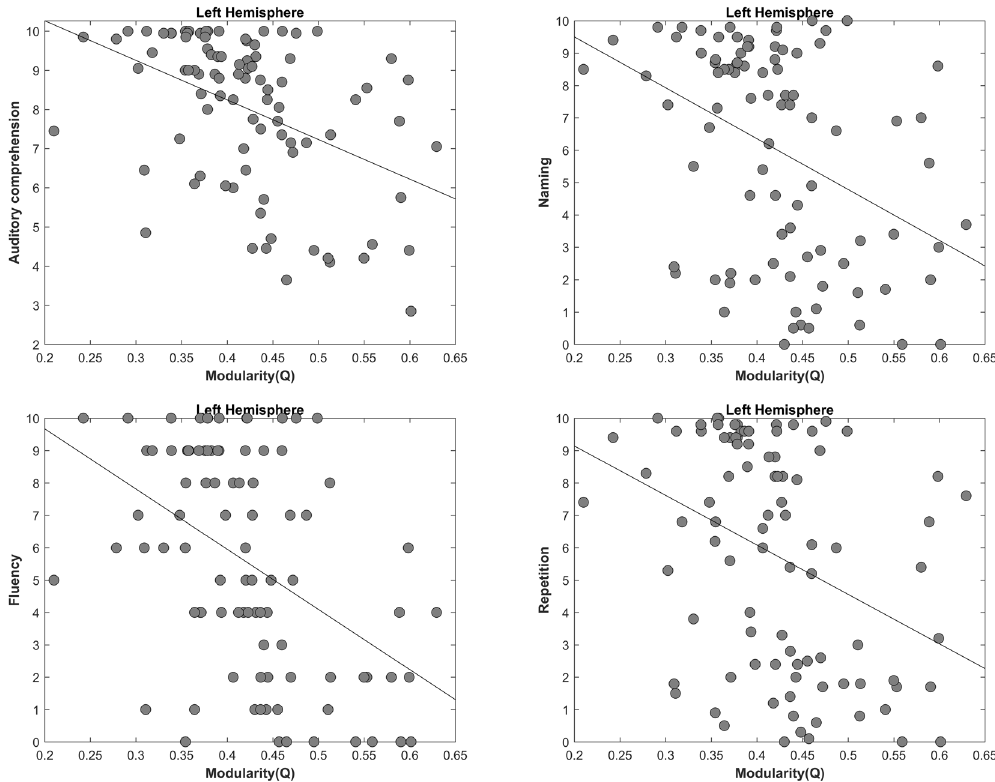
Figure 2. Correlation between left hemisphere modularity and subsets of WAB-AQ: Auditory comprehension (r = − 0.4345, p < 0.00001), Fluency (r = − 0.4561, p < 0.00001), Naming (r = − 0.3948, p < 0.00001), and Repetition (r = − 0.3644, p <